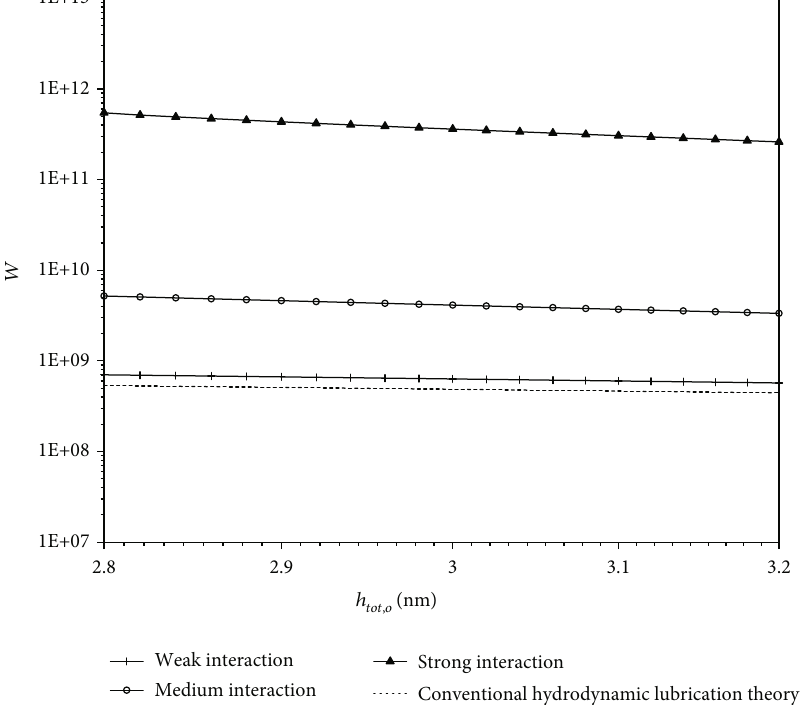
Figure 11: Dimensionless carried load of the present model of the bearing.